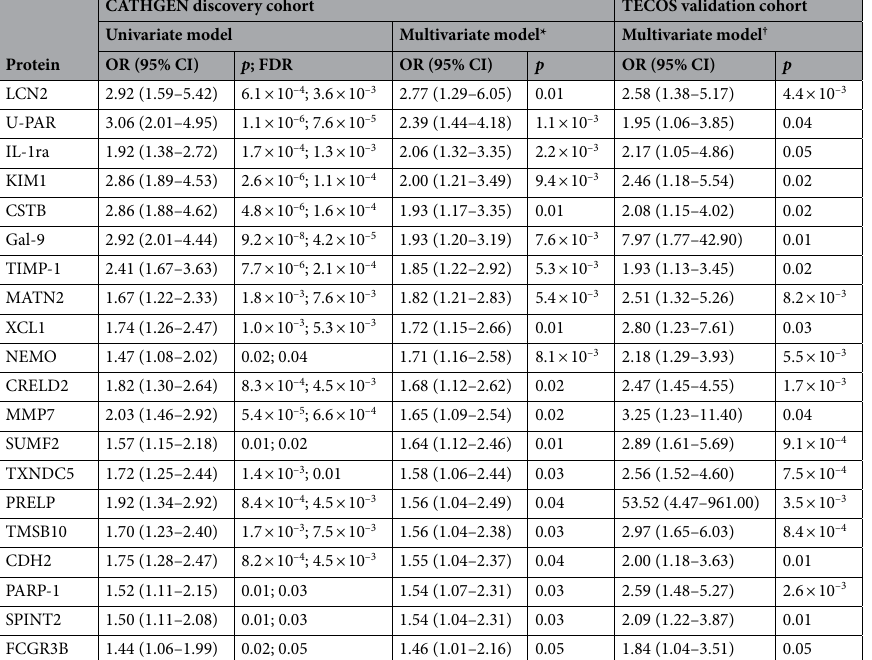
(Fig. 3, Supplemental Table S7a). Similarly, addition of the 20 individual validating proteins to the adjusted model with NT-proBNP improved the AUC to 0.87 ( p = 0.02) in CATHGEN and 0.94 ( p = 4.7 × 10 –5 ) in TECOS. In exploratory sex-stratified analyses, the selected set of proteins performed equally well in males and females in CATHGEN (Supplemental Table S7b). Prognostic capability of HFpEF proteins for incident adverse events.